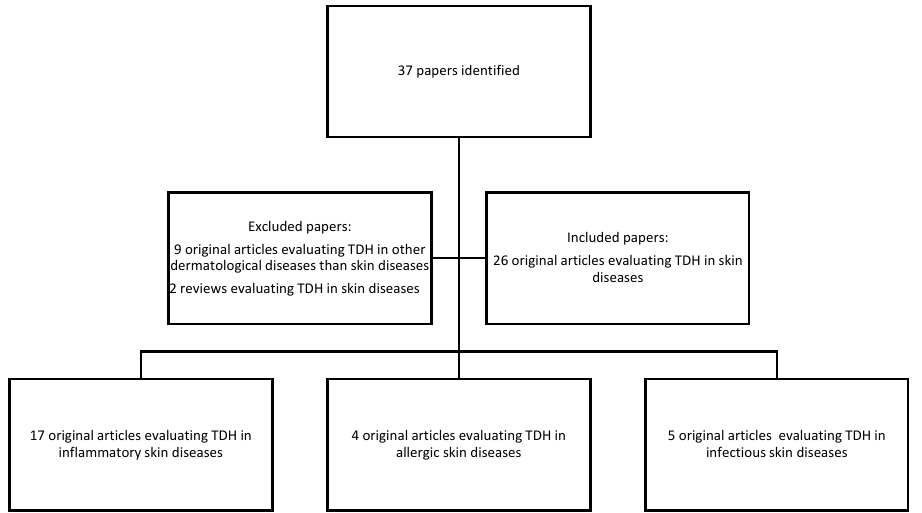
Figure 1. The selection criteria of the articles evaluated in this